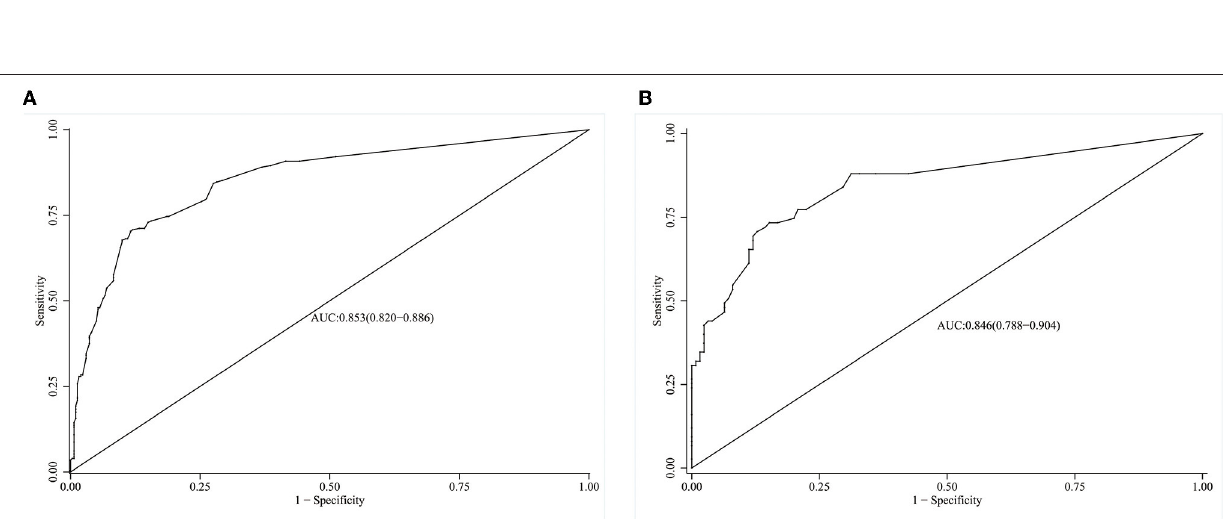
Frontiers in Pediatrics |